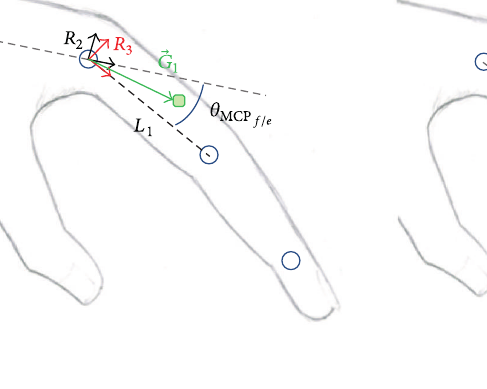
Figure 4: Dynamic model of